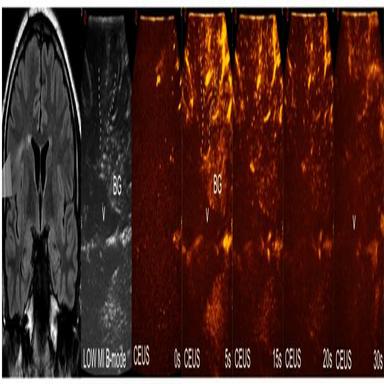
comparison between coronal FLAIR weighted image, B-mode (extreme left) ioUS (middle left) and CEUS images (on the right, acquired at different times from MBs injection). On the FLAIR image the FCD presented as a thickened cortical layer and elongated subcortical hyperintensity extending towards the right lateral ventricle (the light grey prism exemplifies the orientation of ioUS beam). At low frequency grey scale imaging, the dysplastic zone showed a faint hyperechogenicity (delimited by light grey dotted l